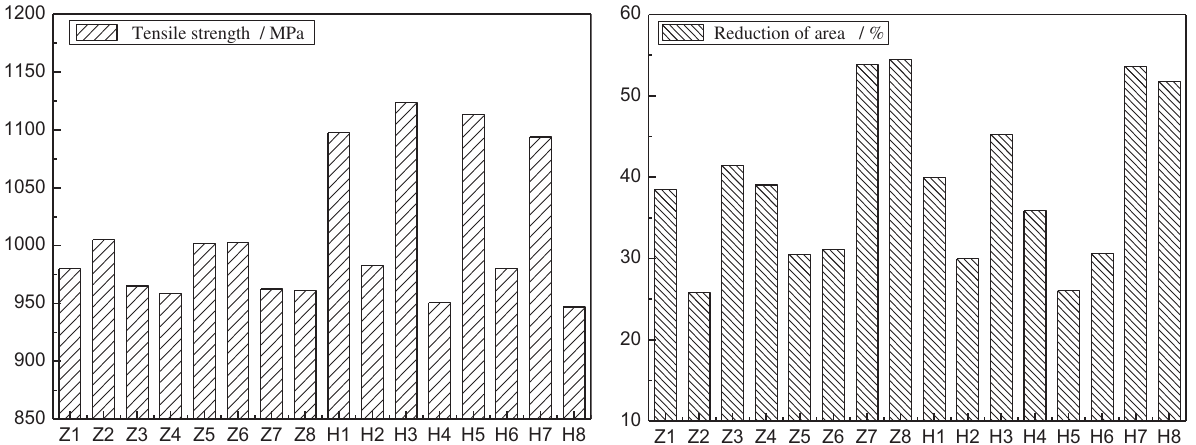
Figure 5: Tensile strength of the studied rolling bar before/after heat treatment.